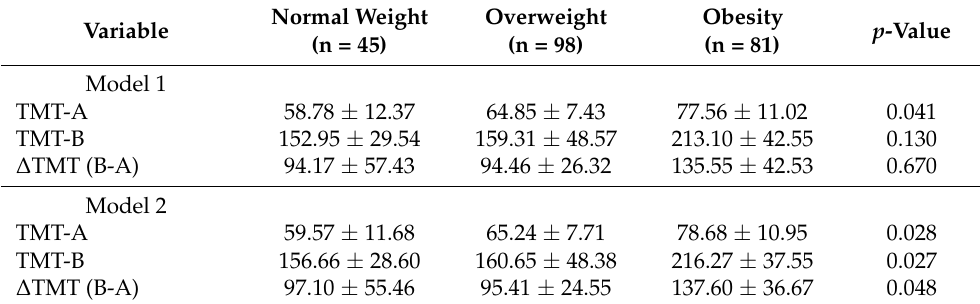
Table 3. Comparisons of executive function performance in different BMI groups. Variable